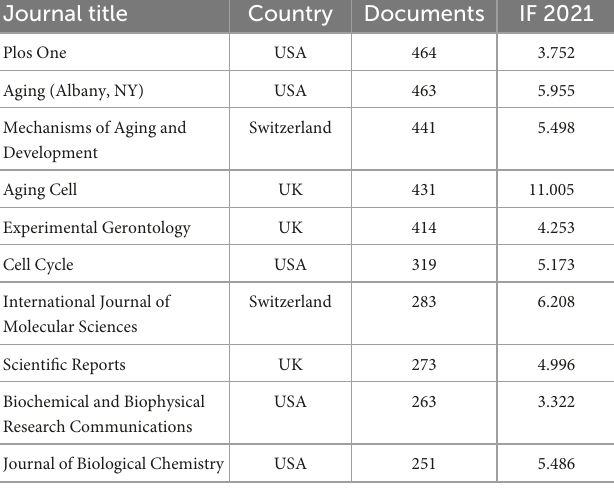
TABLE 1 Top 10 journals with most publication related to cellular